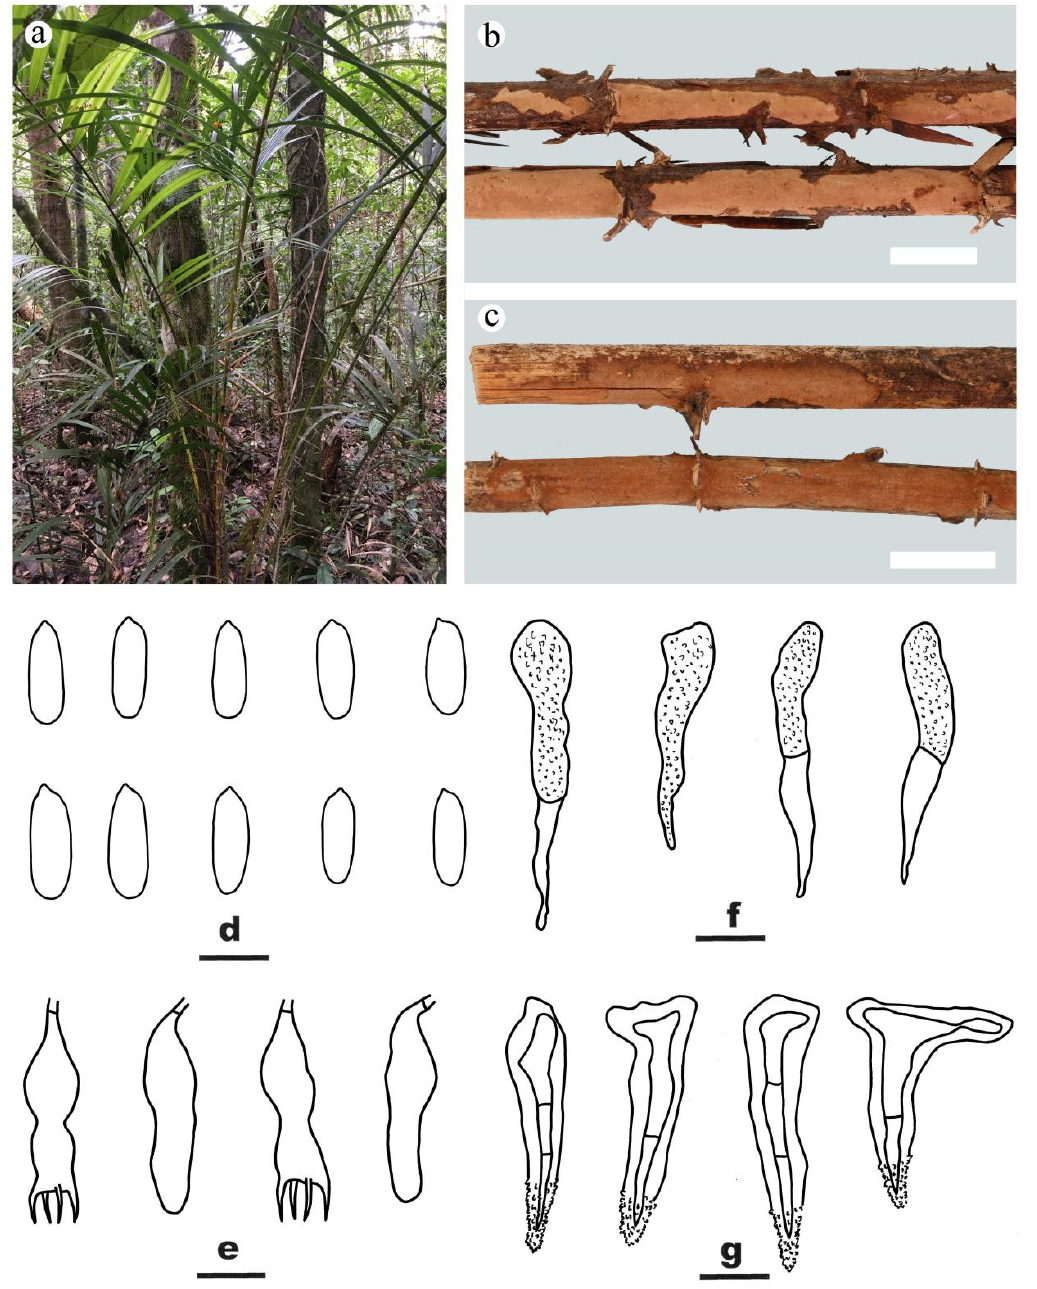
Figure 6. Peniophora vietnamensis (( a , c – g ) from the holotype BJFC 024770; ( b ) from the paratype BJFC 024760). Scale bars: ( b , c ) = 1 cm; ( d – g ) = 10 µm. ( a – c ). Basidiomes; ( d ). Basidiospores; ( e ). Basidia